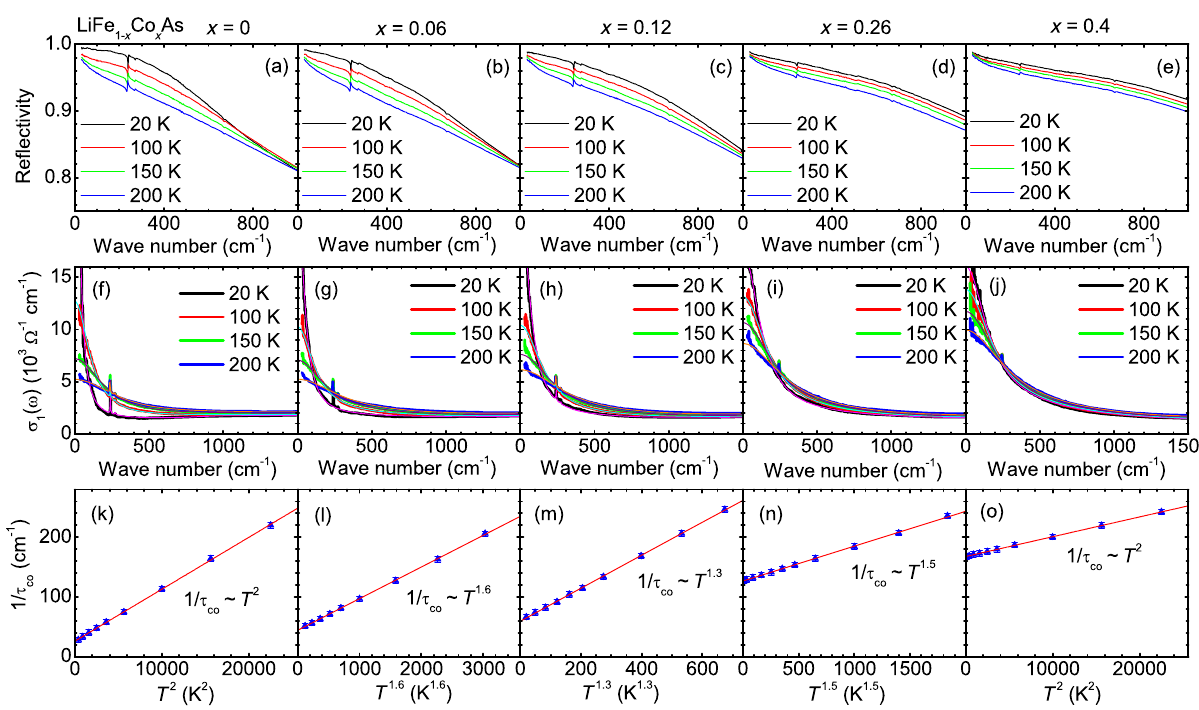
FIG. 7. Reflectivity, optical conductivity, and quasiparticle scattering rate of LiFe 1 − x Co x As. (a) – (e) Temperature dependence of the reflectivity of LiFe 1 − x Co x As in the far-infrared region at several temperatures for the stoichiometric material and 4 representative Co concentrations. (f) – (j) Real part of the optical conductivity derived from the reflectivity. The thick solid curves are the experimental data and the thin solid curves through the data denote the Drude-Lorentz fitting results. (k) – (o) Scattering rate of the coherent narrow Drude component ( 1 = τ ) as a function of T α . The straight solid line in each panel is a guide to the eye. co